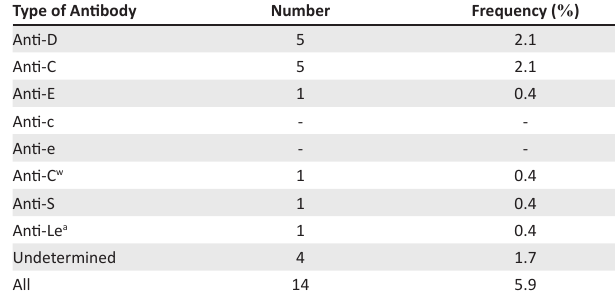
TABLE 1: Social and demographic characteristics of patients with chronic renal failure, Yalgado Ouedraogo Teaching Hospital of Ouagadougou, Burkina Faso, 2018.